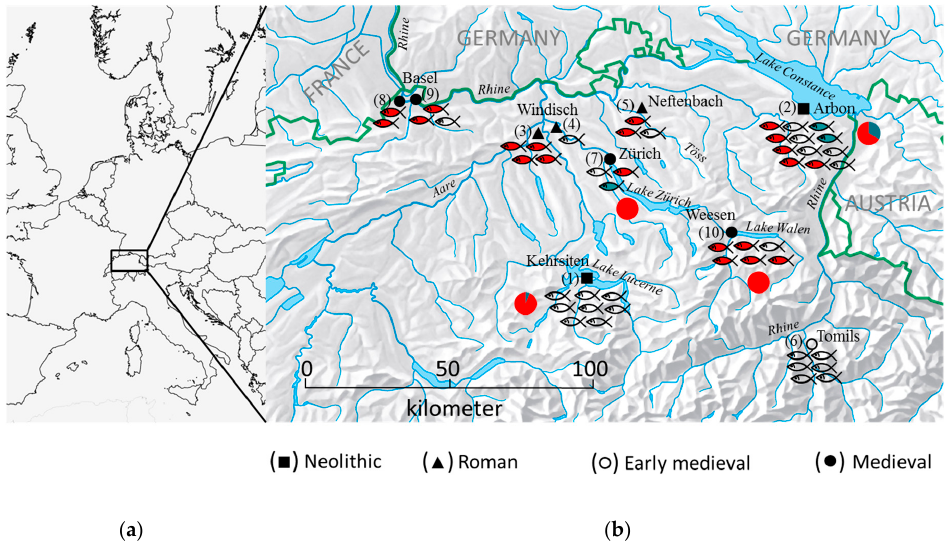
Figure 1. ( a ) Switzerland within Europe and ( b ) showing an enlarged part of Switzerland with the locations of cities and archaeological sites (numbers in parenthesis) providing the samples for this study. Main lakes and rivers are in italics. Number of fish symbols corresponds to number of archaeological samples tested per site. Pie charts represent extant samples from Lake Lucerne ( n = 49), Lake Zürich ( n = 20), Lake Walen ( n = 23), and Lake Constance ( n = 42) (as listed in Table S2). Red coloured fish symbols and pie charts denote C lineage; blue coloured fish symbols and pie charts denote N lineage; empty fish symbols denote no aDNA detected. (1) Stansstad-Kehrsiten